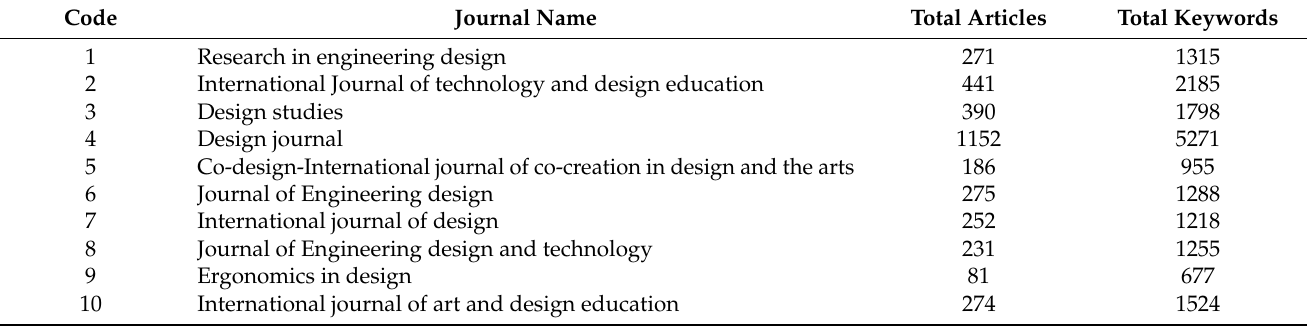
Table 1. Journal list and summary of articles and keywords ranged from 2007–2019.